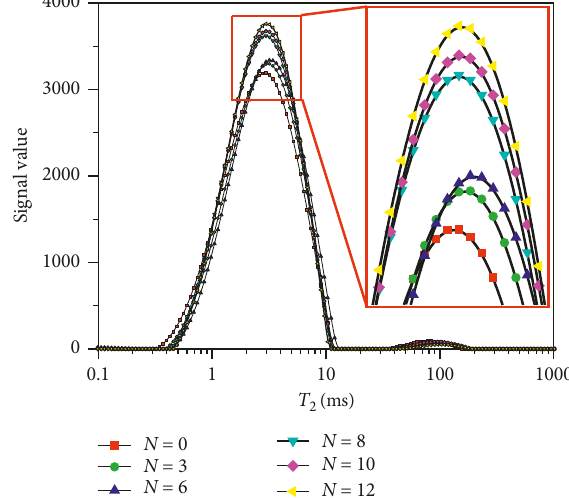
Figure 12: T2 curves of argillaceous limestones after the cycle effect of